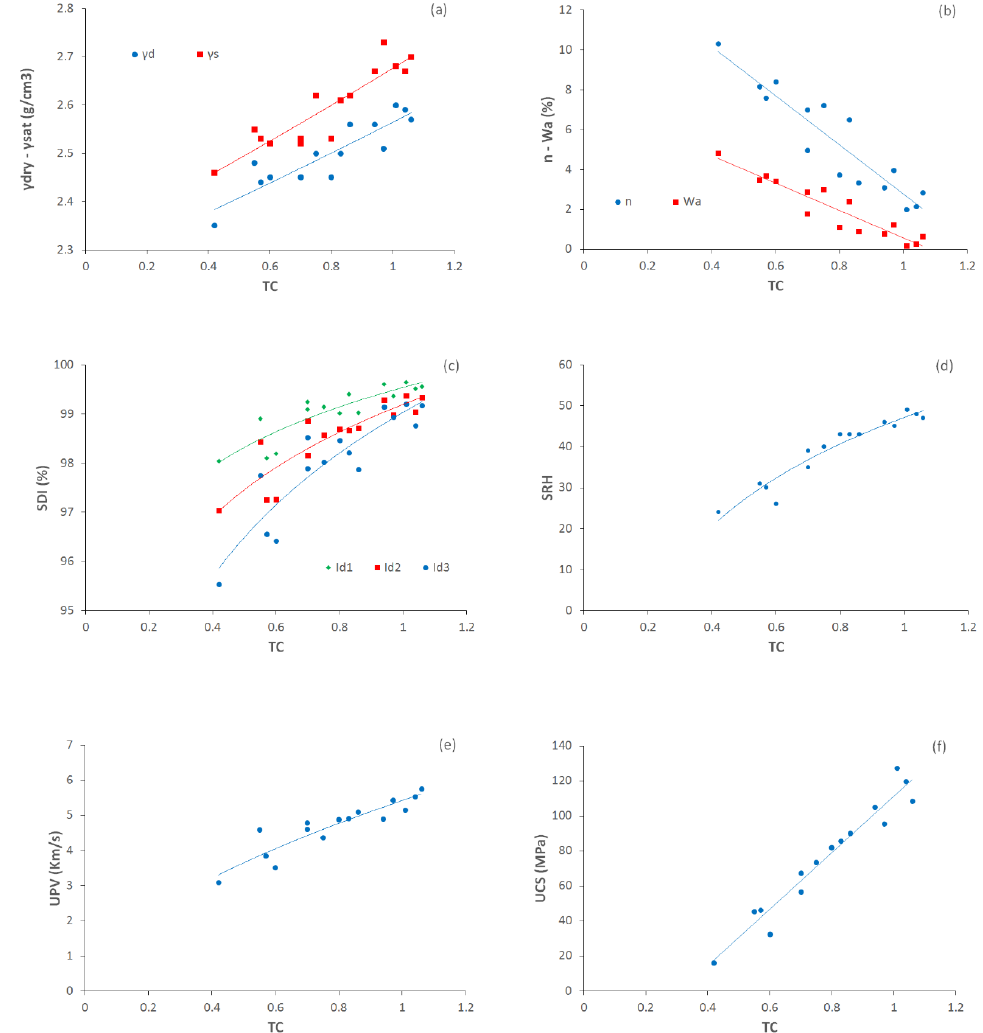
Figure 9. Relations between texture coefficient (TC) and ( a ) dry and saturated unit weights ( γ d , γ s ), ( b ) effective porosity (n) and water absorption (W a ), ( c ) slake durability index (SDI), ( d ) Schmidt rebound hardness (SRH), ( e ) P-wave velocity (UPV), ( f ) uniaxial compressive strength (UCS) for the rocks.